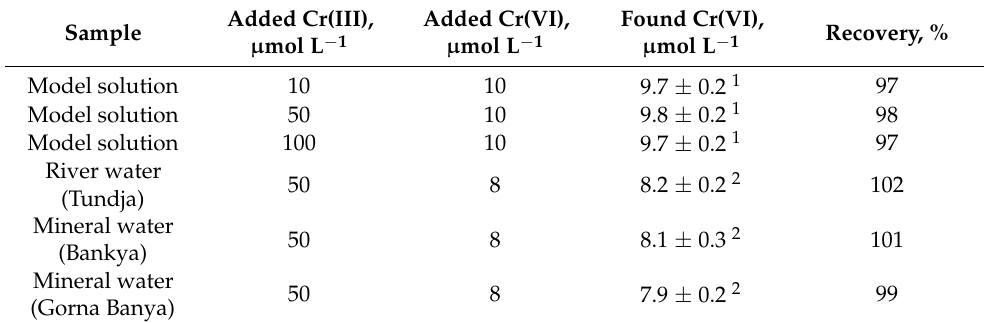
Table 1. Selective determination of Cr(VI) in the presence of Cr(III) in model solutions and water samples (5 parallel determinations).